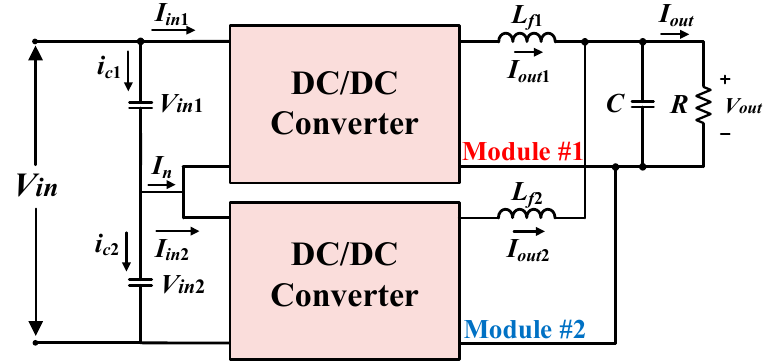
Figure 1. Simplified configuration of Input-Series-Output-Parallel (ISOP) converter